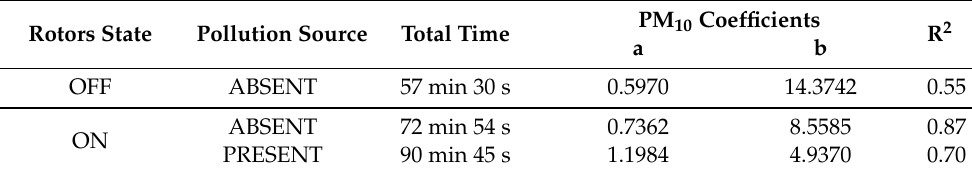
Table 3. Summary of data collected under field